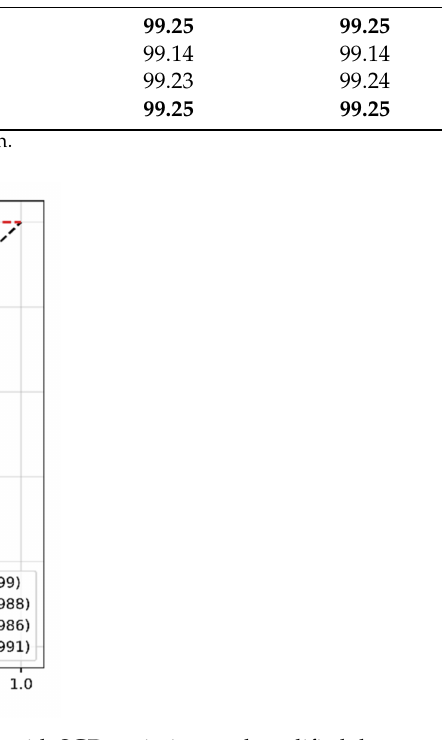
Figure 17. The ROC of the proposed model obtained with SGD optimizer and modified